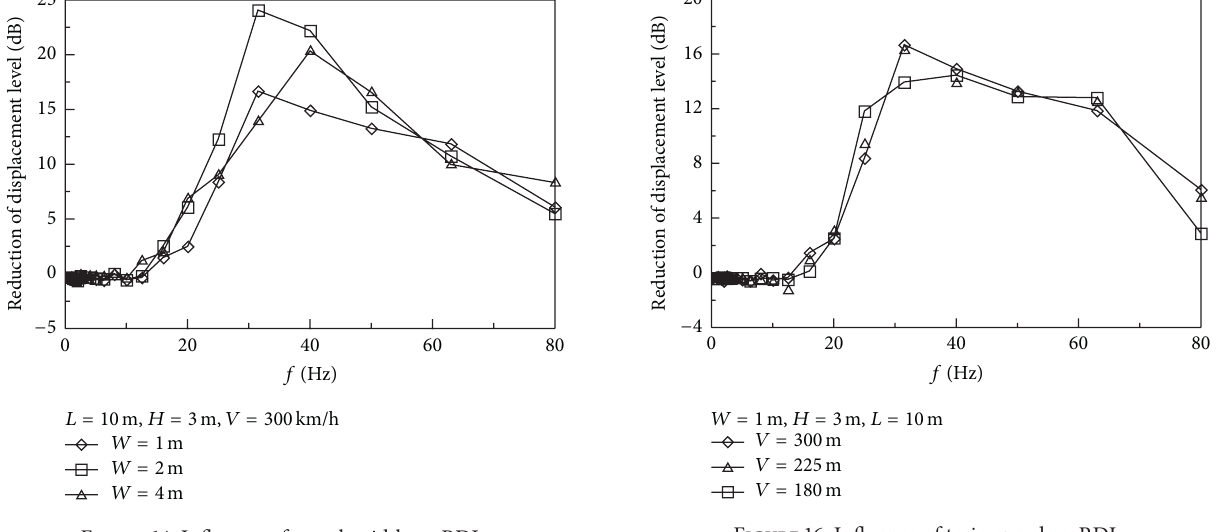
Figure 14: Influence of trench width on RDL.